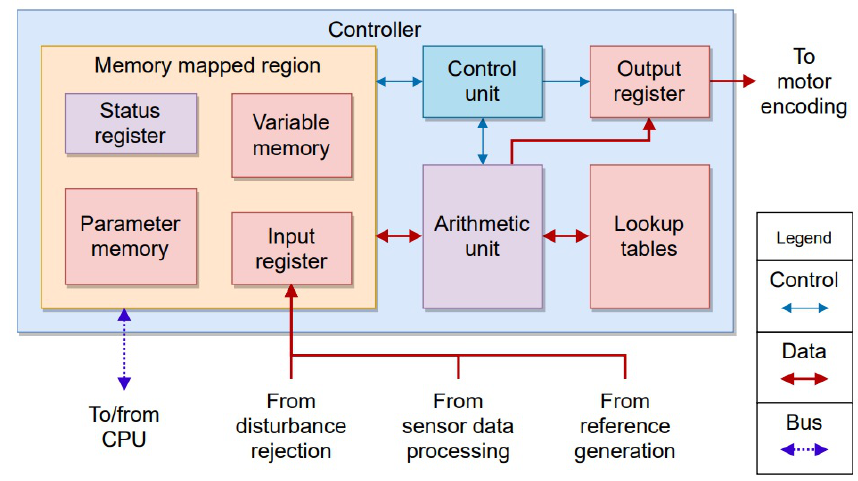
Figure 3. Some detail of the FPGA control